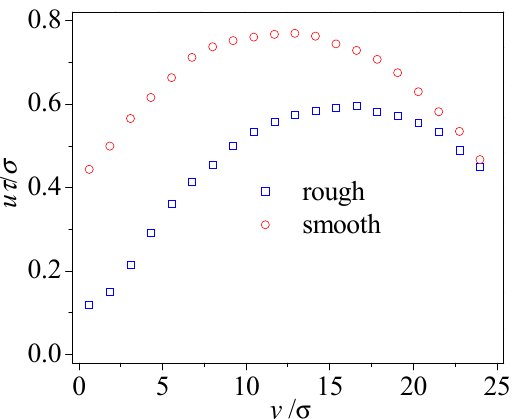
Figure 3. Velocity distributions in the smooth and rough nanochannels ( ρ w = 2 ρ , ε wl = ε , S = 9.4 σ , δ = 1.57 σ ).